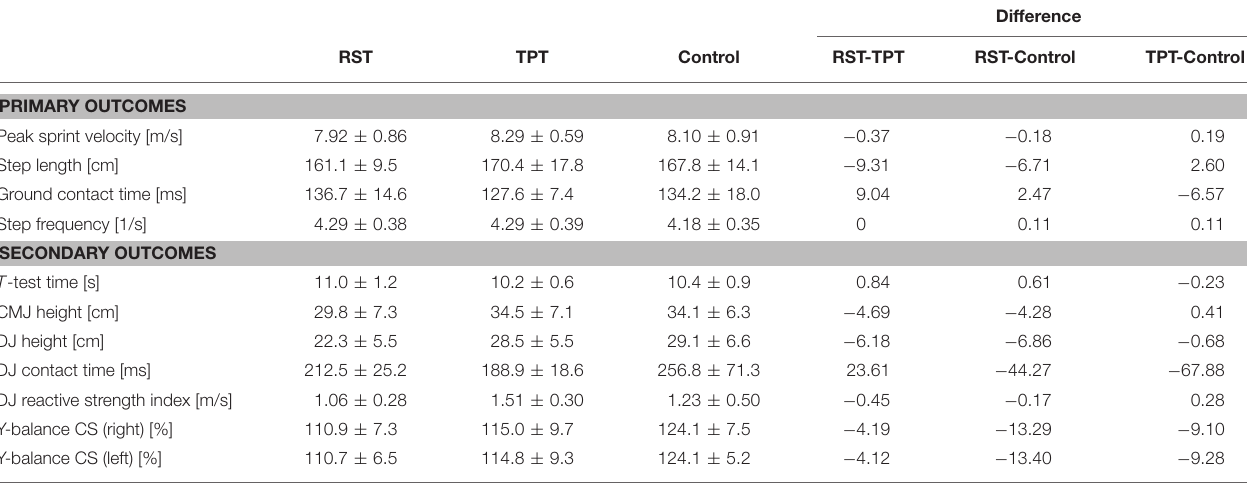
TABLE 3 | Primary and secondary outcome measures at baseline for the resisted sprint training (RST) group, traditional power training (TPT) group, and control group and the respective group differences.